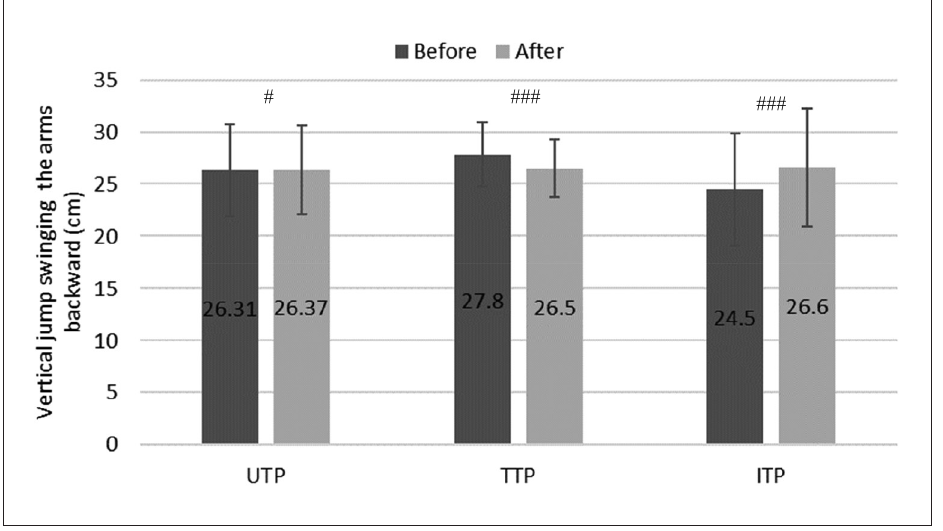
Figure 5. Indicators of 6 min running test (m) of mini-basketball players aged 8–9